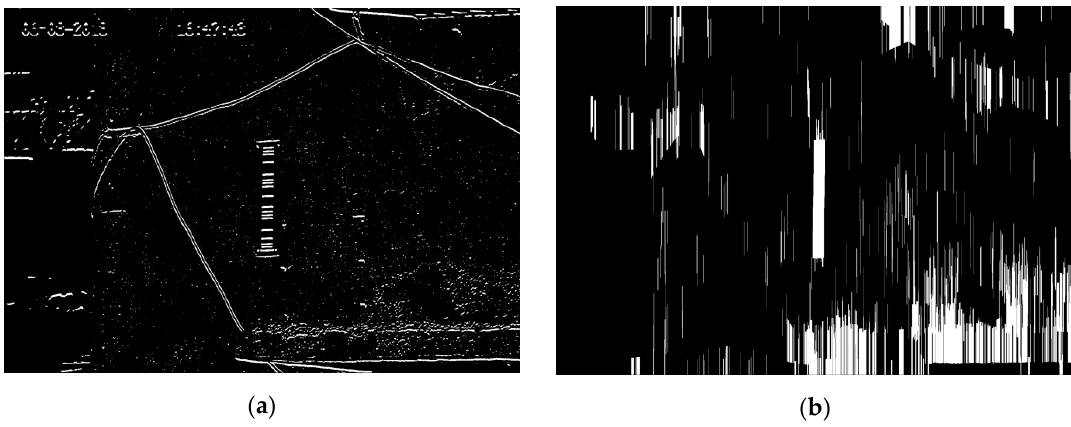
Figure 4. Mark location confirmed, ( a ) Sobel transverse edge detection; ( b ) the image after the operation of erosion, dilation and erosion. The white region in the middle of the image is the region of the stripes.